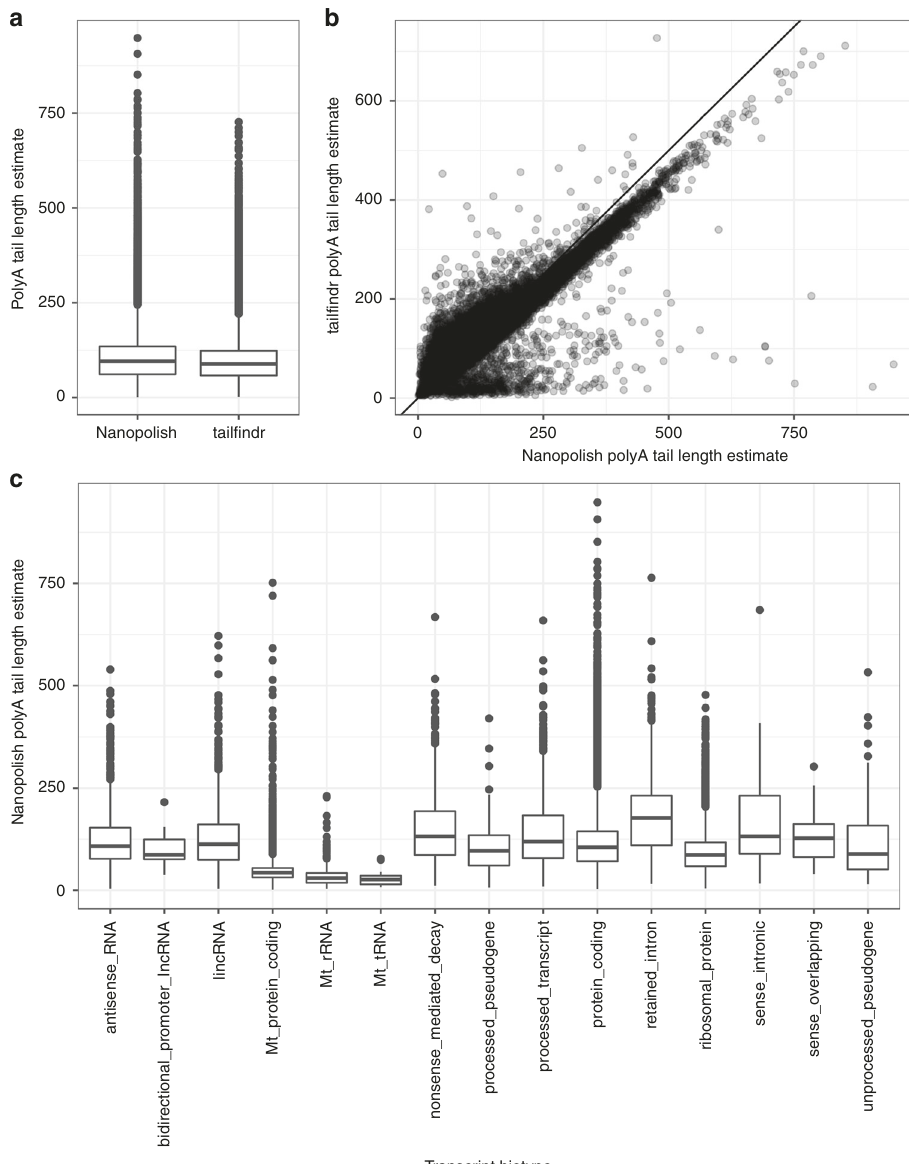
Fig. 8 Evaluation of polyA tail length estimates. a Overall distribution of polyA tail length estimates from Nanopolish and tail fi ndr. b Agreement between polyA tail length estimates from Nanopolish ( x ) and tail fi ndr ( y ). c Distribution of estimated polyA tail lengths for reads assigned to transcripts of different biotypes. Only biotypes with at least 10 assigned reads are shown. For boxplots, the center line represents the median; hinges represent fi rst and third quartiles; whiskers the most extreme values within 1.5 interquartile range from the box. In these plots, a single outlier read with a polyA tail length